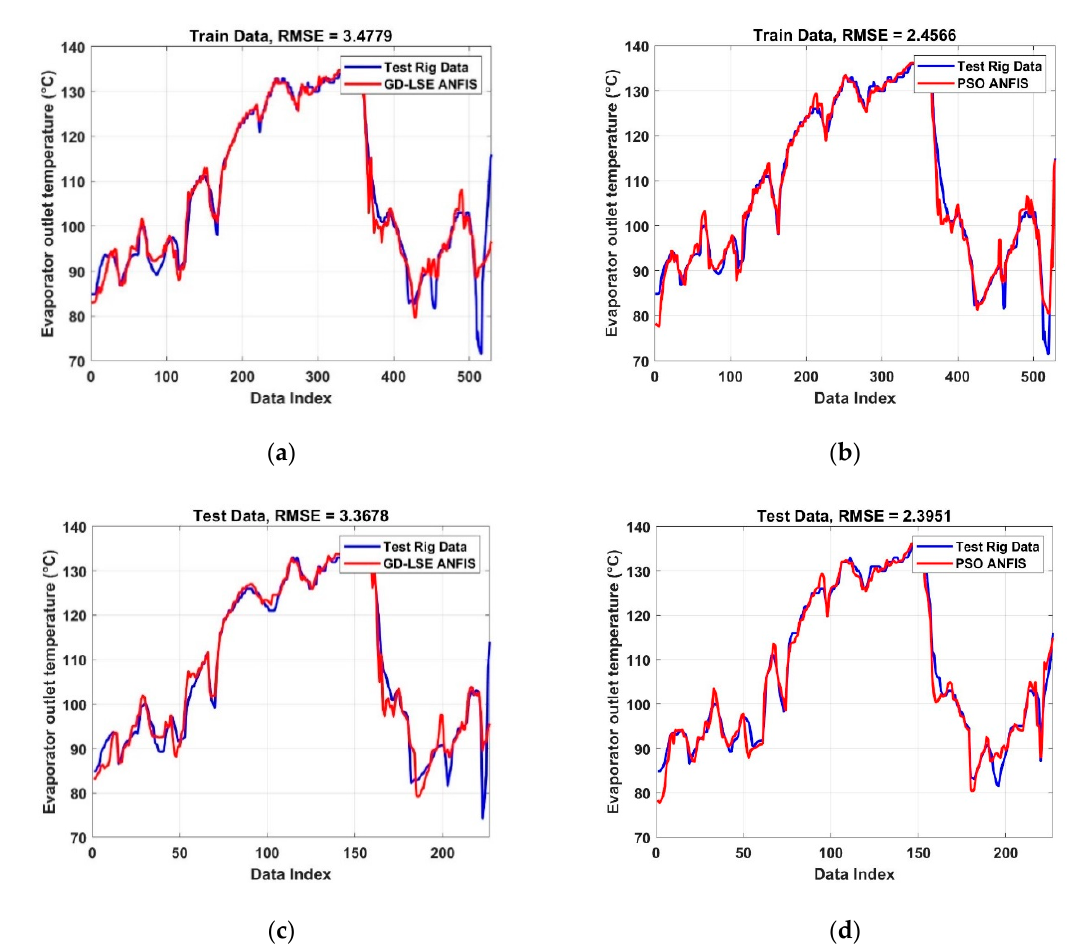
Figure 5. Comparison of GD-LSE ANFIS and PSO ANFIS model predictions of the evaporator outlet temperature, T r,out , using training and test data: ( a ) training data (GD-LSE); ( b ) training data (PSO); ( c ) test data (GD-LSE); and ( d ) test data (PSO).